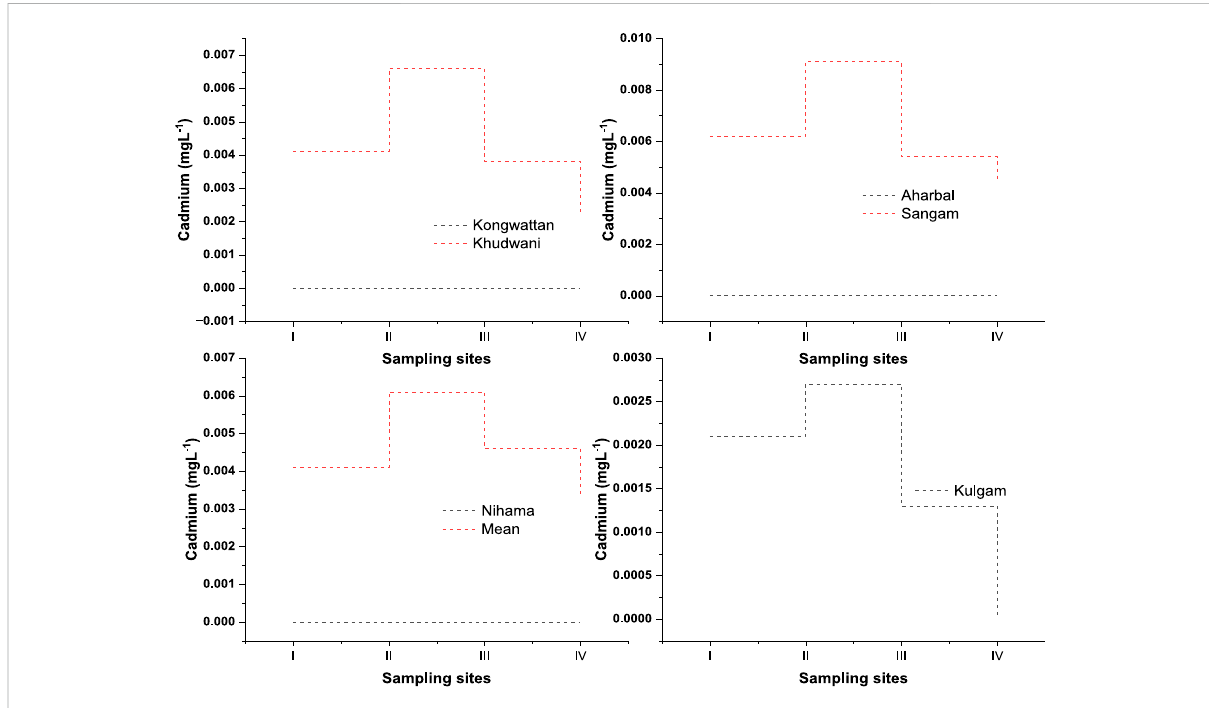
FIGURE 3 Figure depicting the comparative time-series seasonal variation analysis of Cadmium (Cd) in the water of the River Veshaw at six different sites collected during all the seasons from spring to winter (I:spring; II:summer; III:autumn; IV:winter; V) Each symbol represents the mean of triplicate